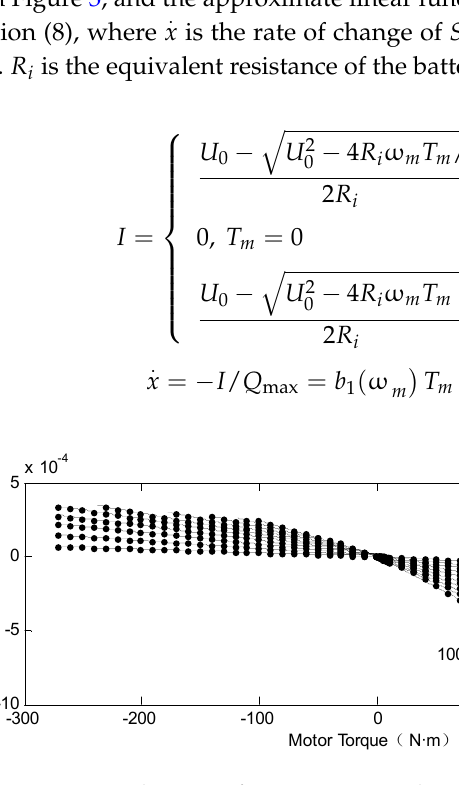
Figure 3. Fitted curves of motor torque and state of charge ( SOC ) change.